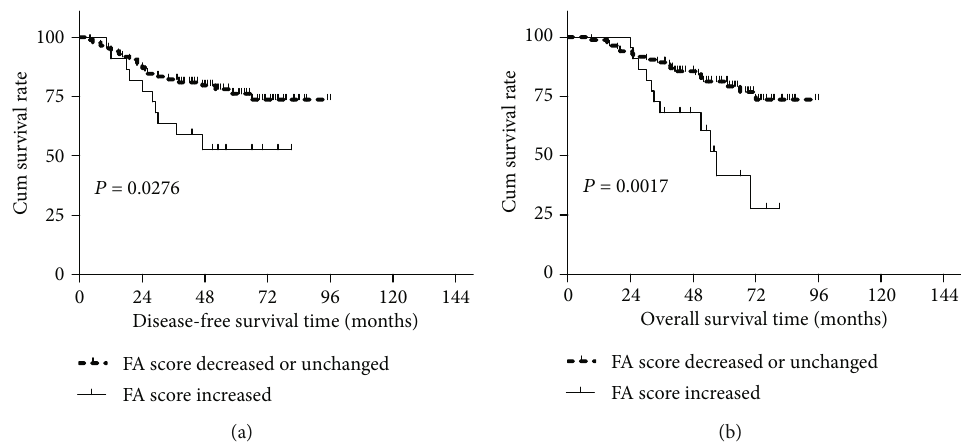
Figure 1: Correlation between changes in FA scores and prognosis of LARC patients. Patients in the increased FA score group exhibited a signi fi cantly worse disease-free survival (a) and overall survival